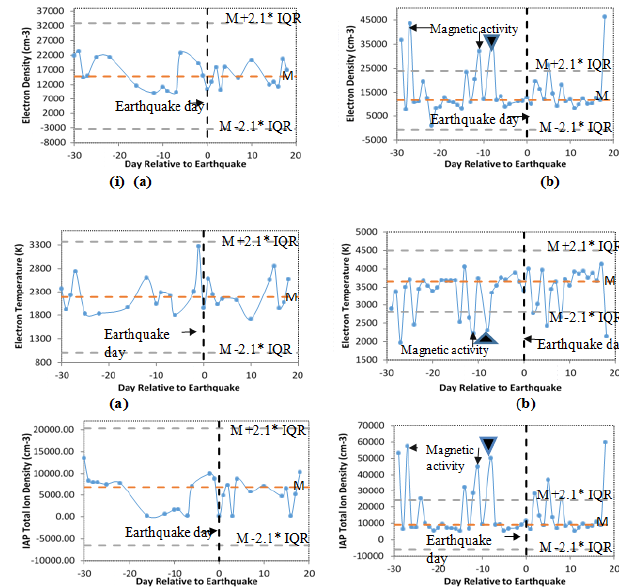
Figure 2: Line plots from statistical analysis of DEMETER data for the East of Kuril Island Earthquake (13 th January, 2007). Ionospheric plasma parameters of electron density, electron temperature and total ion density respectively are plotted against day relative to the earthquake (a) nighttime measurment and (b) daytime measurement.The small red triangles show depicted anomaly eight days before the event in quiet geomagnetic conditions.